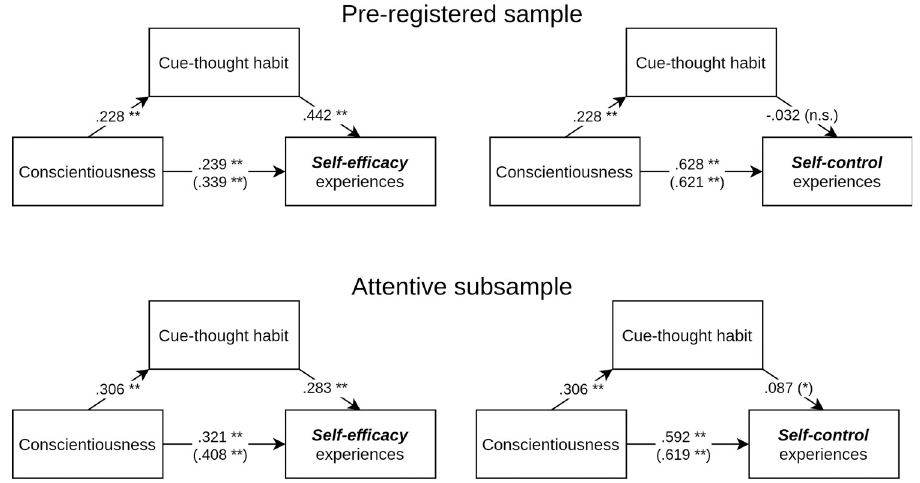
Fig 1. Standardized coefficients for the cue-thought habit mediation between conscientiousness and self-efficacy/ control (pre-registered and attentive subsample). Note. �� p < .01, � p < .05, ( � ) p < .10, n.s. p > .10.